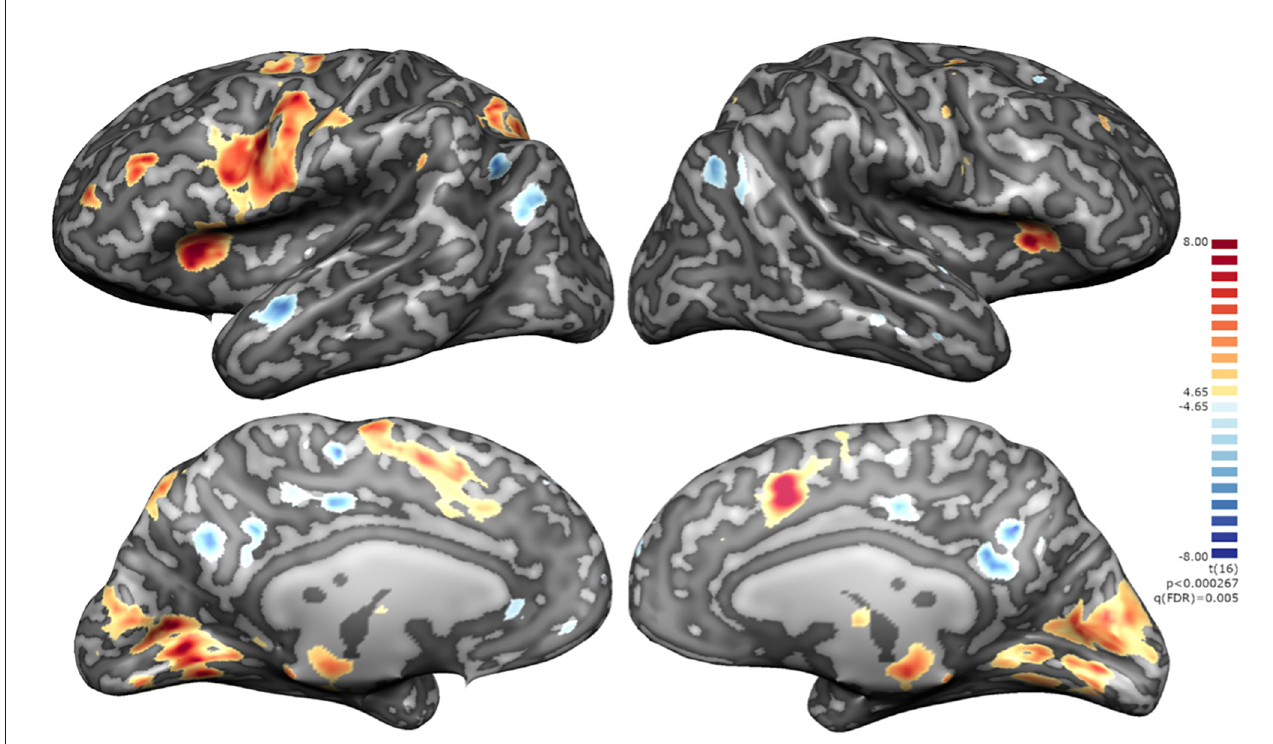
FIGURE6 Whole-brain statistical maps of the NF runs for the active group. Positive clusters integrating the executive network with a left lateralization of fronto- parietal activations and negative clusters integrating the default mode network namely mOFC, CCGp and precuneus, middle temporal gyrus (MTG), angular gyrus and parahippocampal cortex [q(FDR) on the neurofeedback runs].